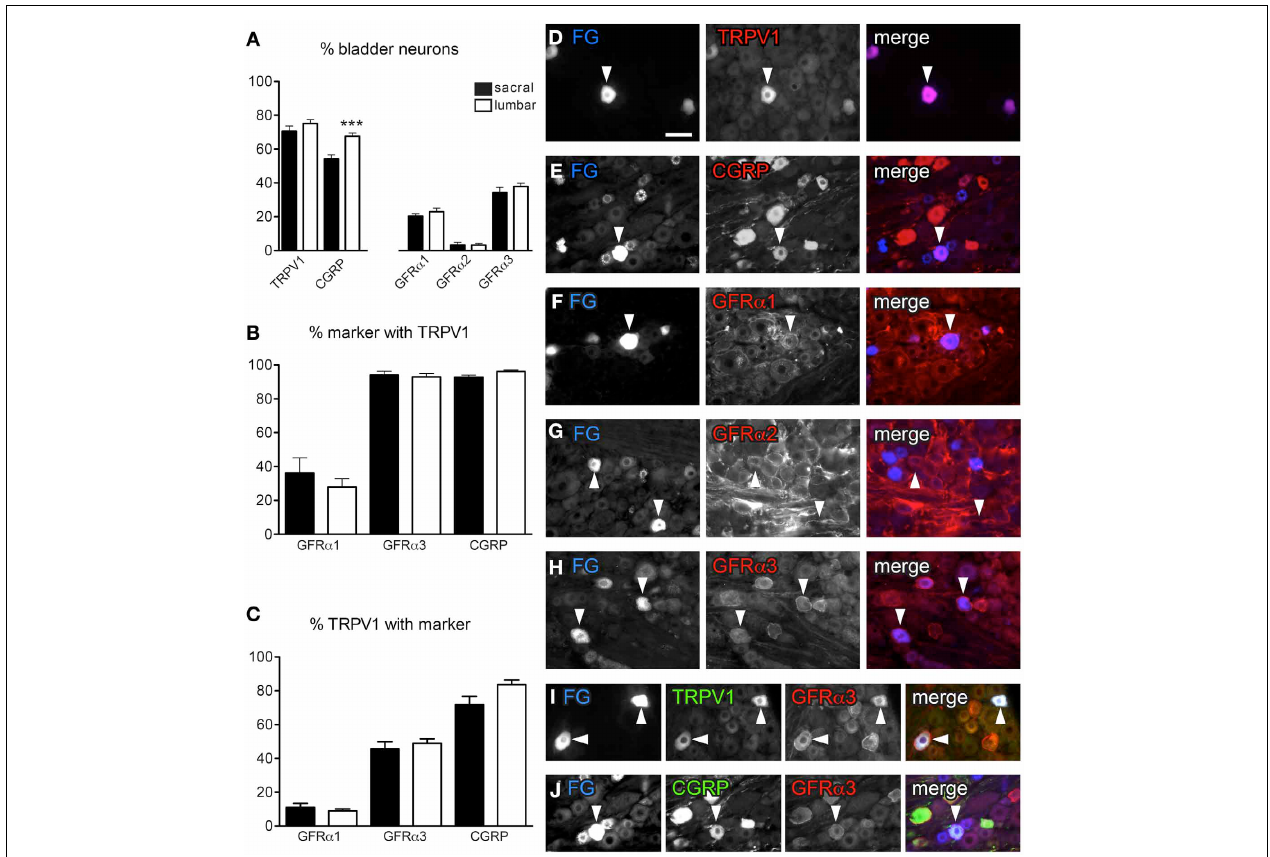
FIGURE 1 | Distribution of TRPV1-, CGRP-, and GFR α -immunoreactivity (IR) in bladder sensory neurons. (A) The proportion of bladder sensory neurons containing TRPV1-, CGRP-, and GFR-(IR) at each spinal level. Bladder-projecting neurons were identified with the retrograde tracer, FluoroGold (FG). A higher proportion of FG-labeled neurons contain CGRP-IR in lumbar than sacral DRGs ( ∗∗∗ P < 0 . 001). ( B) The proportion of GFR α 1-, GFR α 3-, and CGRP-IR bladder sensory neurons co-expressing TRPV1-IR. (C) The proportion of TRPV1-IR bladder sensory neurons co-expressing GFR α 1-, GFR α 3-, or CGRP-IR. (D–J) : Each row of micrographs comprises images from the same field, showing immunostaining for one or more markers in retrogradely-labeled bladder sensory neurons. The first panel shows the